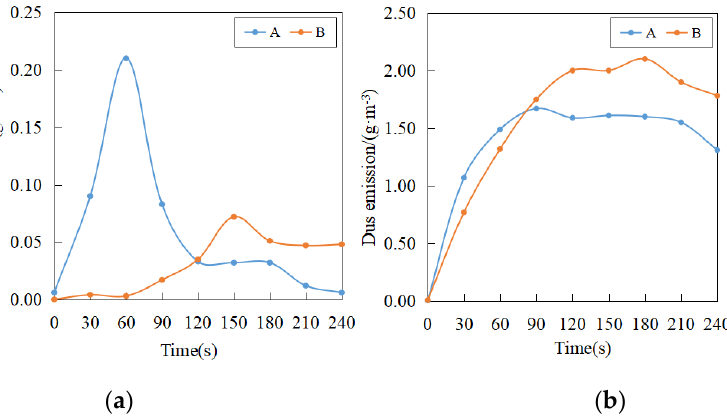
Figure 10. The dust amount of coal during loading varied with time under different charging methods. ( a )-New method of coal charging; ( b )-Traditional method of coal charging methods. ( a ) New method of coal charging; ( b ) Traditional method of coal